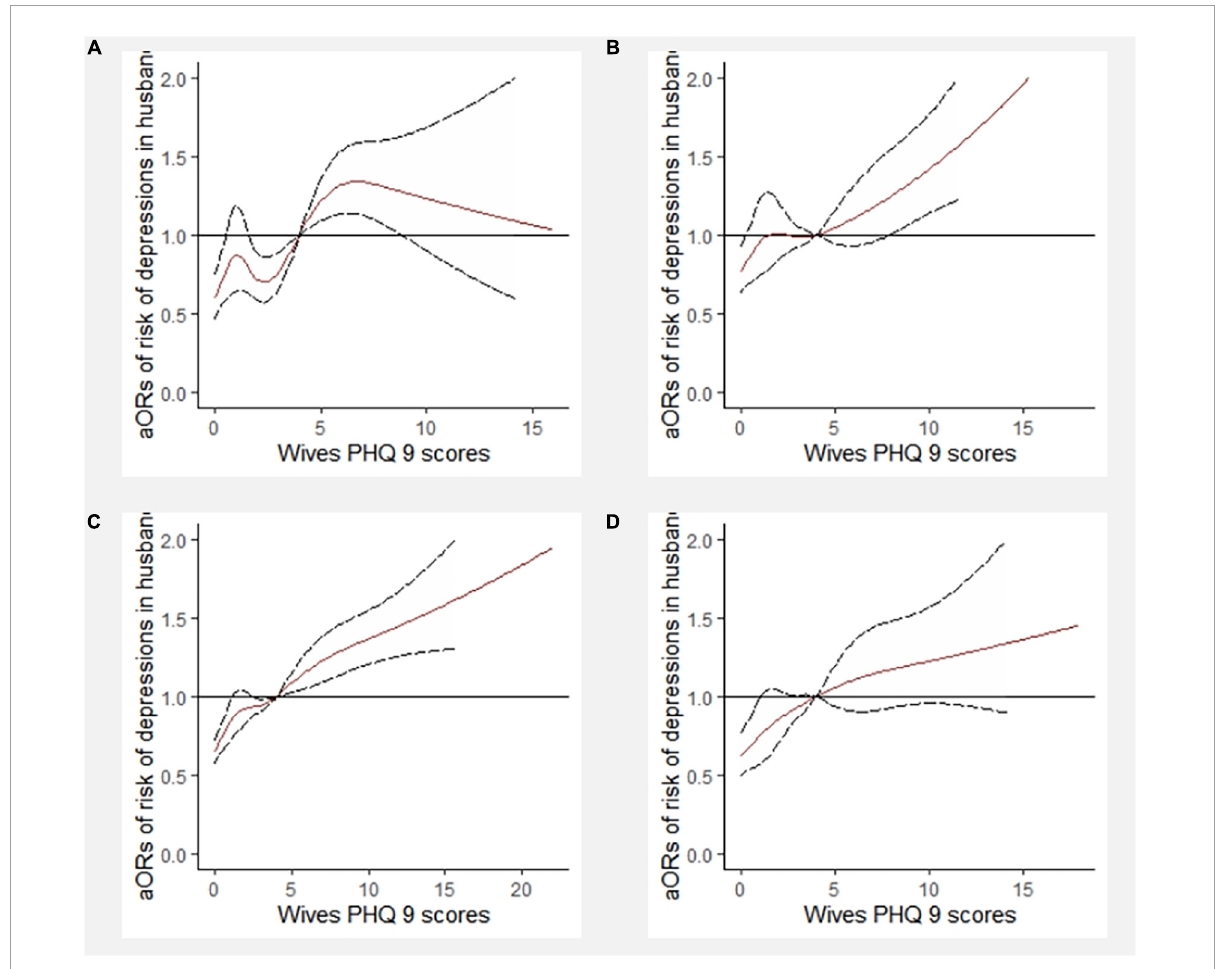
FIGURE8 Dose-response relationship between PHQ-9 scores of wives and depressive symptoms of husbands stratified by socioeconomic status (SES) matching (6 knots). aOR, adjusted odds ratio; PHQ-9, 9-item Patient Health Questionnaire. (A) In the newlyweds with both high-level SES; (B) in the newlyweds with both low-level SES; (C) In the newlyweds with male higher SES; (D) In the newlyweds with female higher